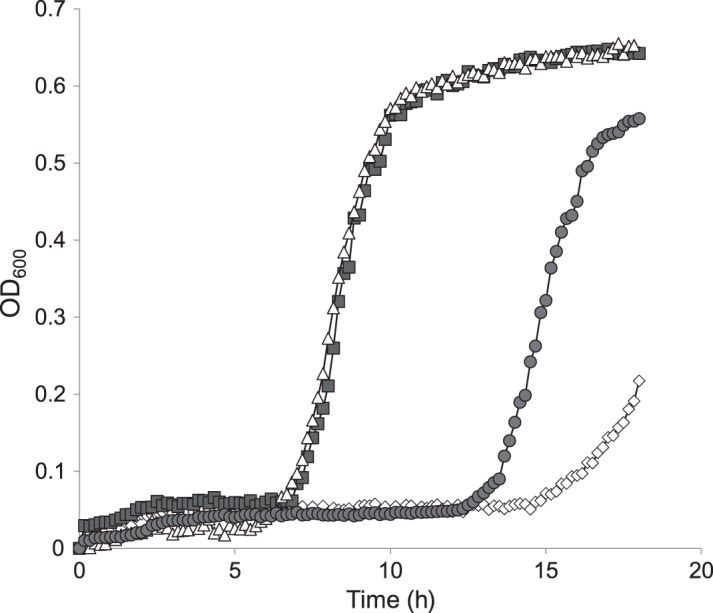
Growth of E. coli BW25113 and derivatives carrying mutations associated with endogenous silver resistance in the presence of 2 mg/L AgNO3. Open diamonds, BW25113; filled squares, BW25113 ompRG596A; open triangles, BW25113 ΔompR; filled circles, BW25113 cusSG1130A.